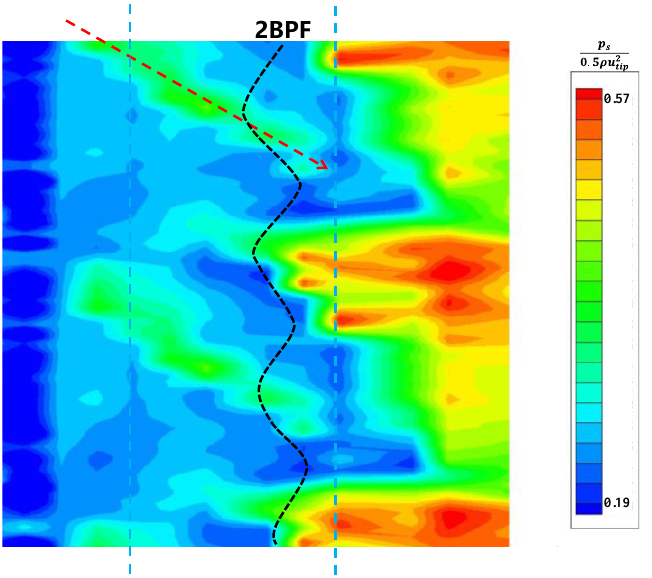
Figure 11. The distribution of the pressure coefficient inside the R1 passage, near the design point .